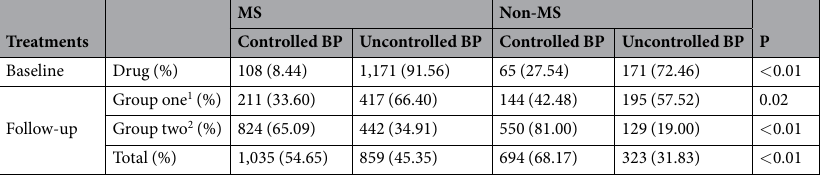
Table 3. The proportion of controlled and uncontrolled BP for patients with hypertension in the MS (JIS criteria) and non-MS groups at baseline and the 1-year follow-up. 1 Only drug therapy, 2 Drug + lifestyle intervention therapy. BP: blood pressure, MS: metabolic syndrome, JIS: the 2009 criteria from the Joint Interim